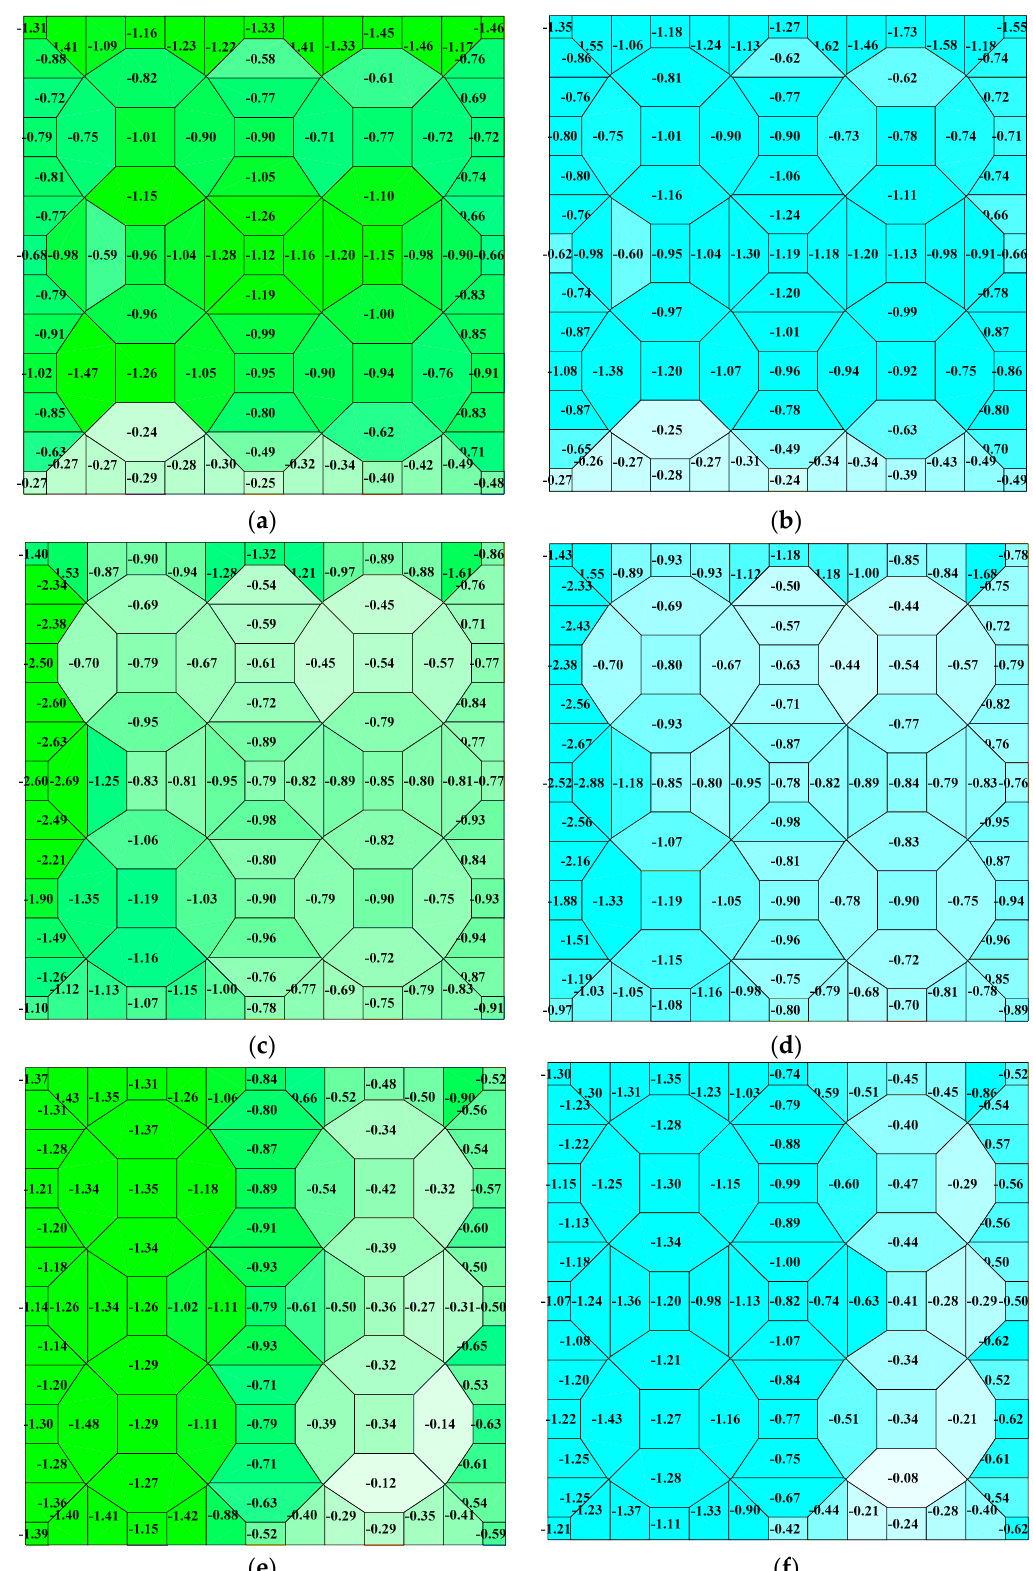
Figure 10. Model 4, mean pressure coefficient maps for α = 0° ( a ), α = 45° ( c ), and α = 90° ( e ); maps using mode of pressure coefficients for α = 0° ( b ), α = 45° ( d ), and α = 90° ( f ).